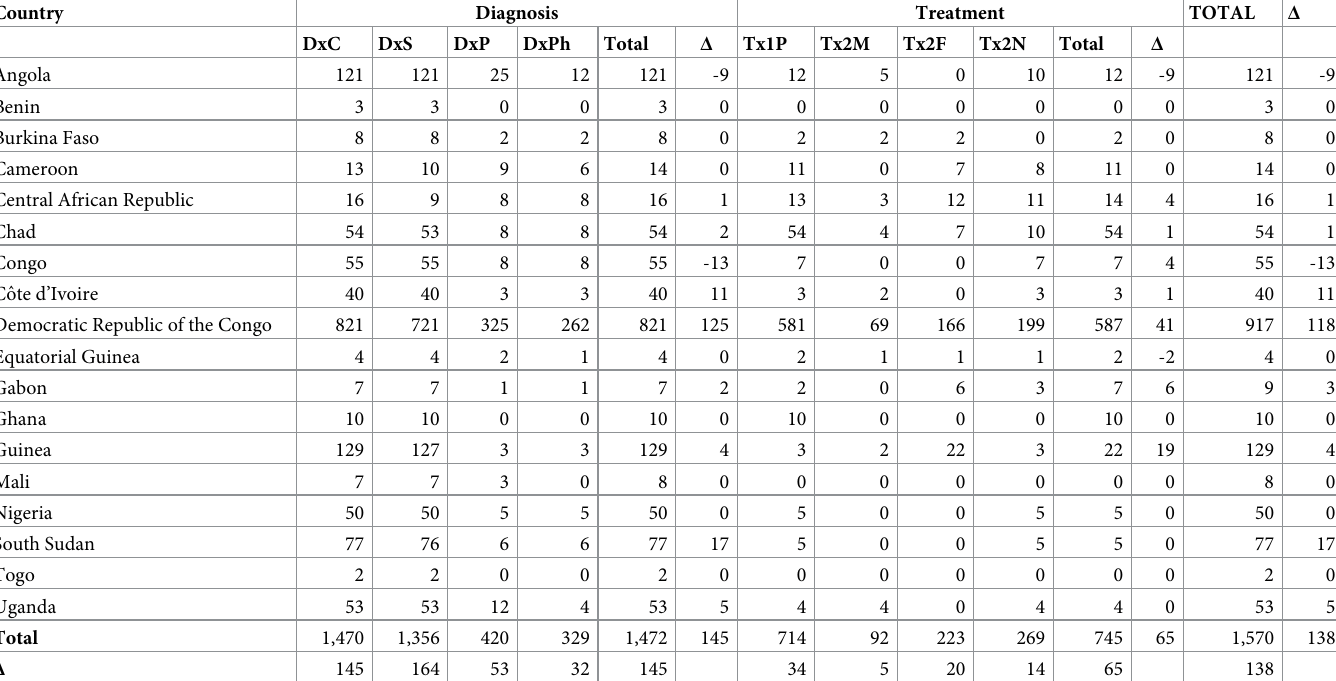
Table 3. Fixed health facilities for gambiense HAT: June 2021 survey. Differences from the July 2019 survey [7] in column ‘ Δ ’. Country Diagnosis